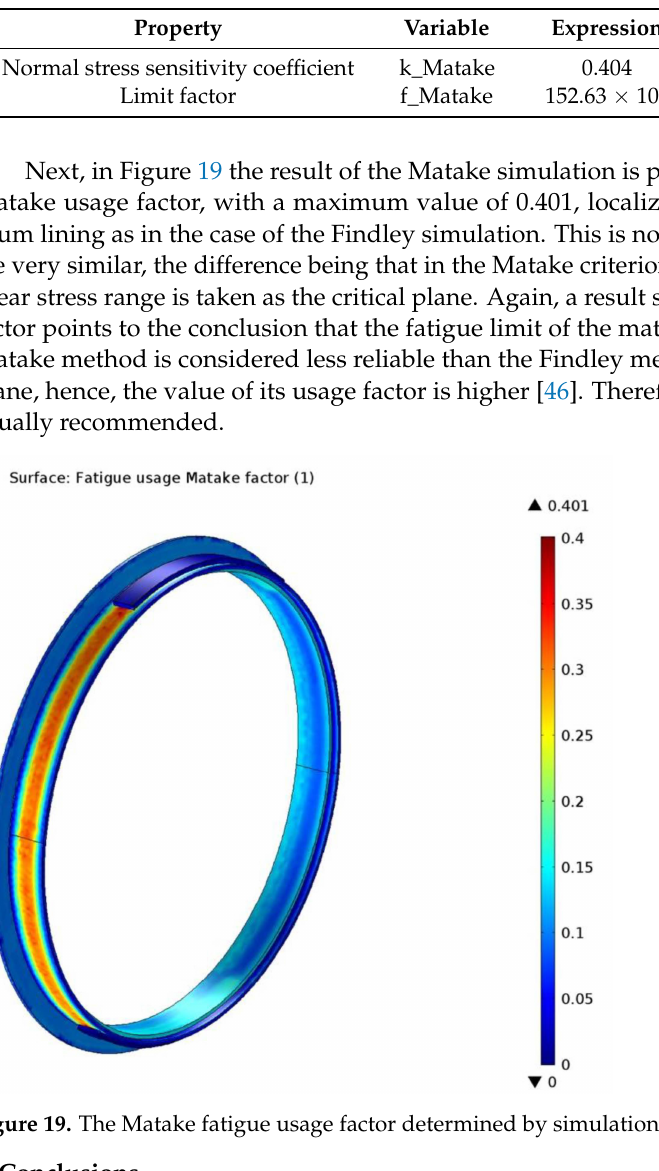
Table 7. Definition of material properties for the Matake Fatigue simulation.